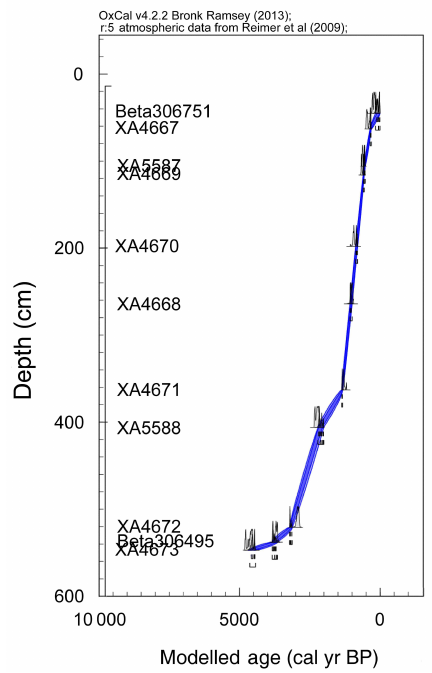
varying between 50 and 100 years and spanning the past ca.